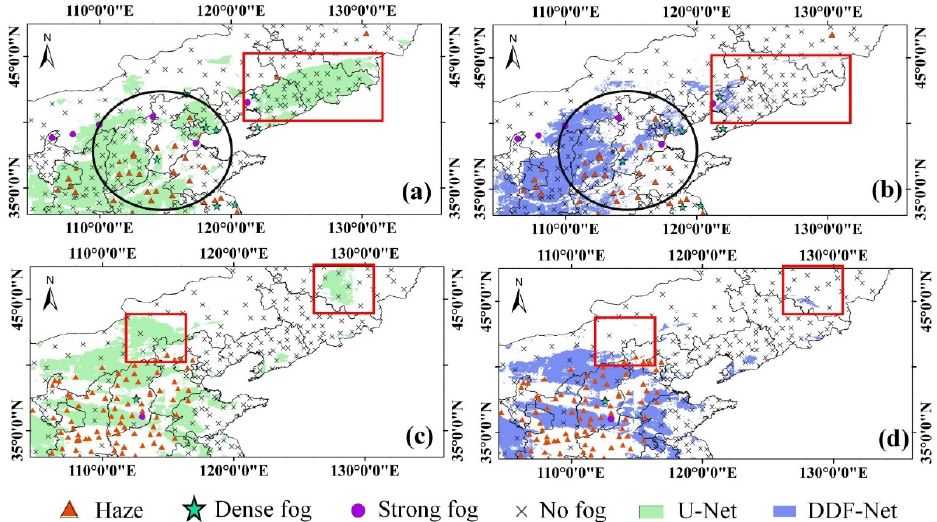
Figure 8. The fog detection results of U-Net and DDF-Net at 08:00 (18 November 2016 ( a , b ) and 12 December 2016 ( c , d )). The triangle, star, circle, and cross symbols represent haze, dense fog, strong fog, and non-fog stations, respectively. The green area is the fog detected by U-Net. The blue area is the fog detected by DDF-Net. All the times are at the Beijing Time (8 h later than the Universal Time Coordinated (UTC)).